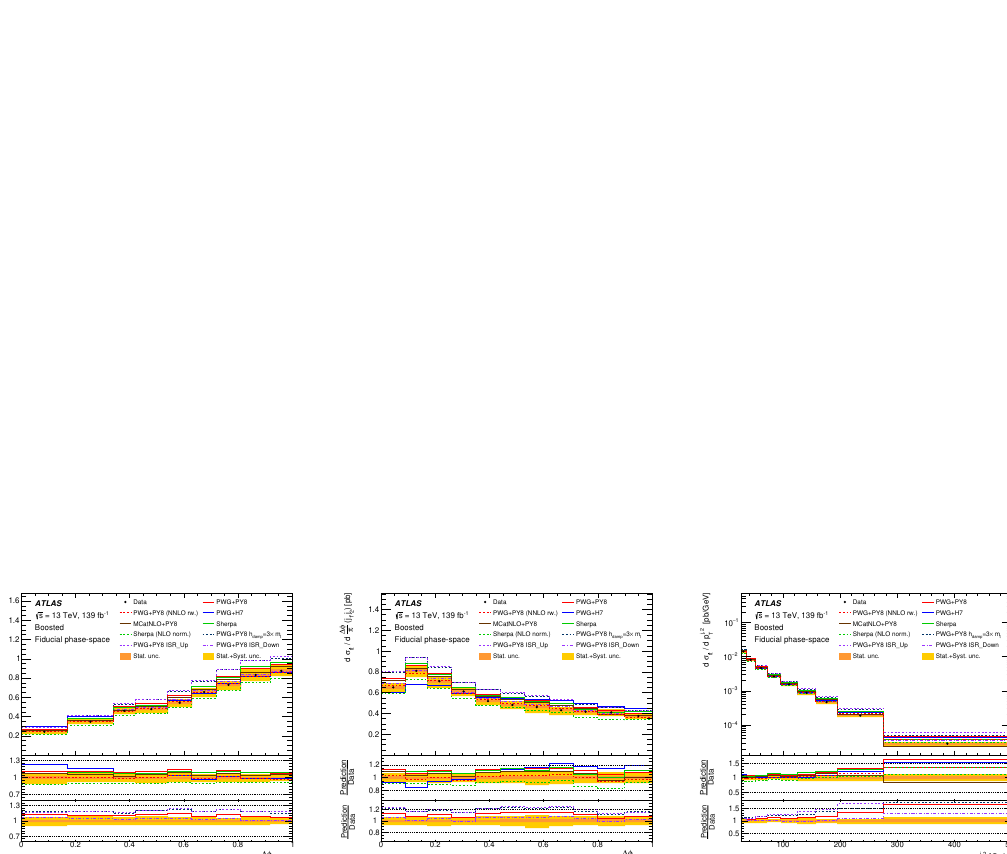
) , (b) ∆ φ ( j ) and (c) , t , j 2 h 1 2